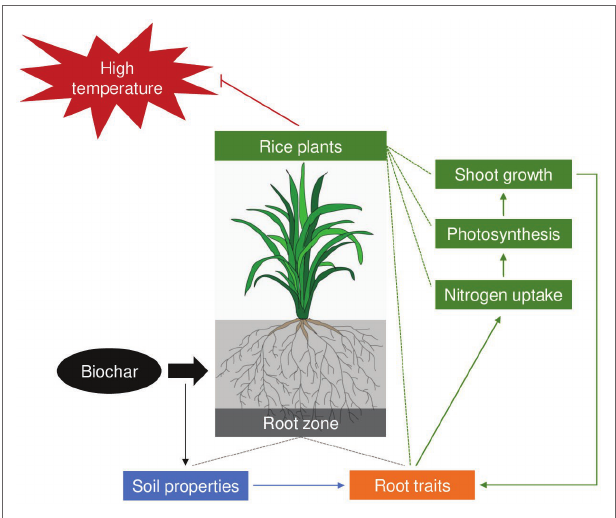
FIGURE 9 | A schematic diagram for the eco-physiological processes underlying the effects of biochar on resistance to heat stress in rice